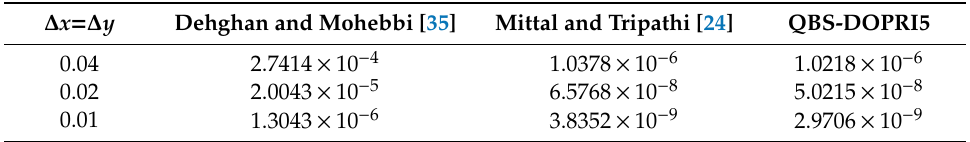
Table 4. Average absolute error values obtained in Example 1 at the time t = 1 s over the